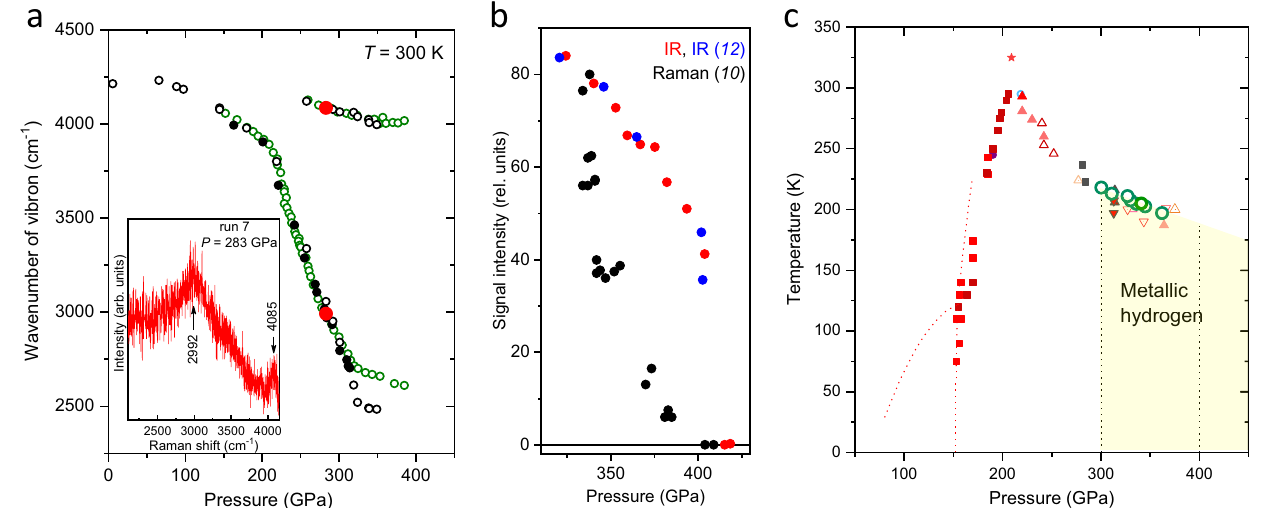
Fig. 4 | Comparison of different experimental studies of hydrogen at high pressures. a Pressure dependence of the hydrogen vibrons at room temperature. Solid black, open black, and open gray circles correspond to data from ref. 9 Open green points are from ref. 33 ; in this work, the pressure scale 30 was used, which is close to the present scale in this pressure range. The pressure for the rest was determined from the present diamond edge scale. Red circles are the data mea- suredinrun7ofthepresentstudy.Theopencircleswereshiftedtolowerpressures by 17GPa to be consistent with the wavenumber of hydrogen vibron at the cali- brated point (red circles). b Comparison of the infrared absorption data 12 (blue circles) and the Raman data 10 . Pressure values for infrared and Raman data were